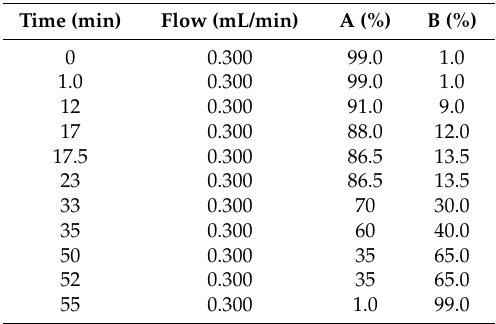
Table 2. Solvent gradient program of UPLC